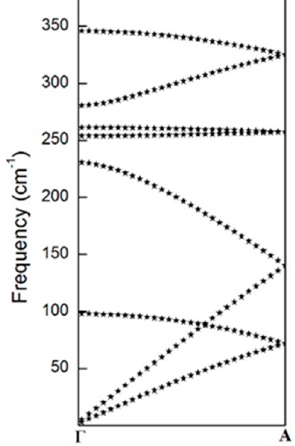
Figure 6. Phonon dispersion curve of WZ ZnS at zero temperature along the chosen Γ – Α path.